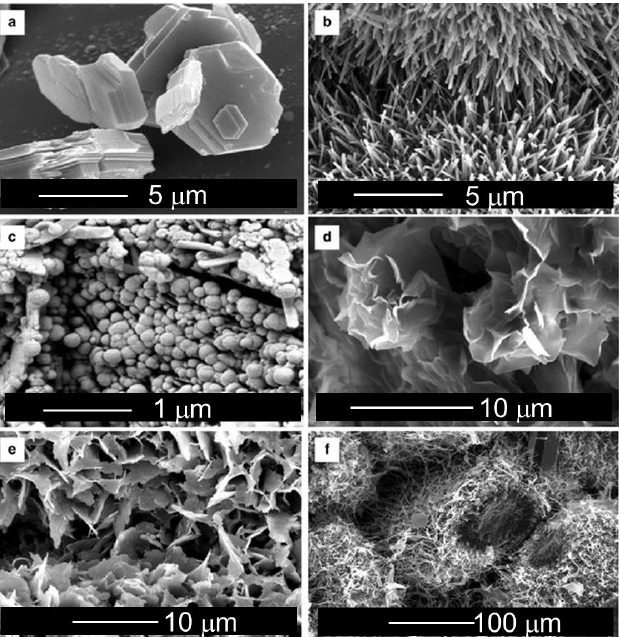
Figure 2. SEM images of clay minerals: ( a ) pseudohexagonal crystals of kaolinite; ( b ) tubular crystals of halloysite; ( c ) spheroidal crystals of halloysite; ( d ) wavy subhedral montmorillonite crystals [9]; ( e ) flaky illite crystals; and ( f ) fibrous illite. Reproduced with permission from [10].